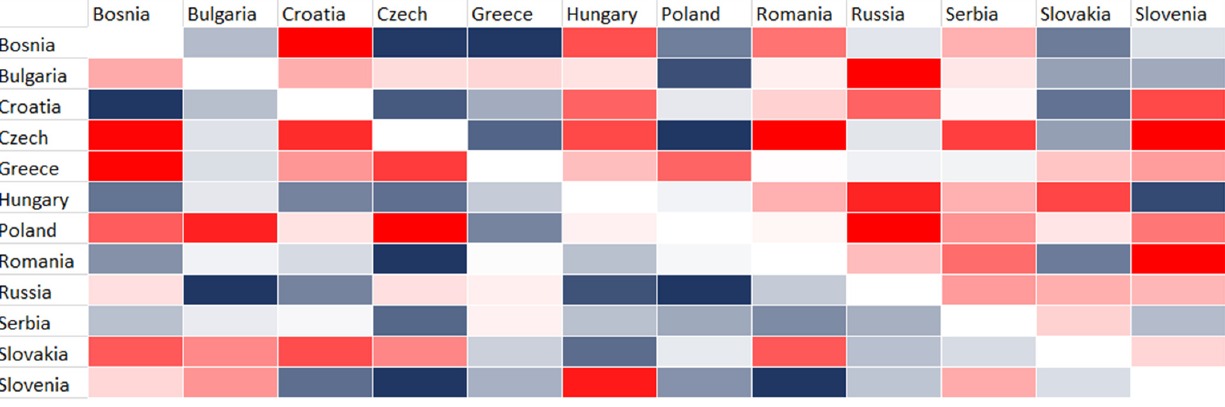
Figure 2. Heatmap of the mean of the net transfer entropy between pairs of stock market indices. Negative values (index is net influenced) are represented in blue and positive values (index is net influencer) in red. The figure is read as the market in the line net influences/is net influenced by the market in the column (considering the transfer entropy levels).